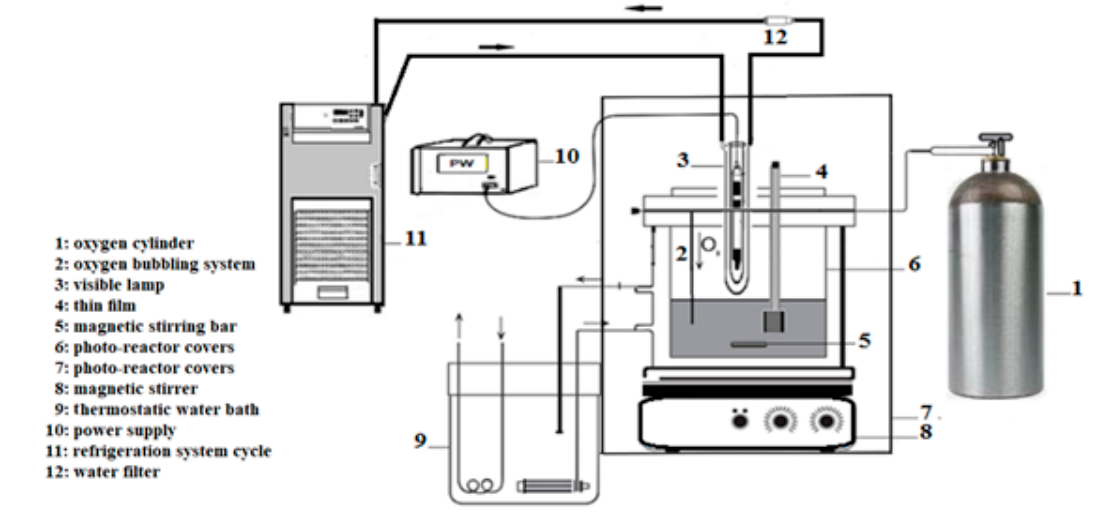
Figure 14. Scheme of the photo-oxidation experimental system.